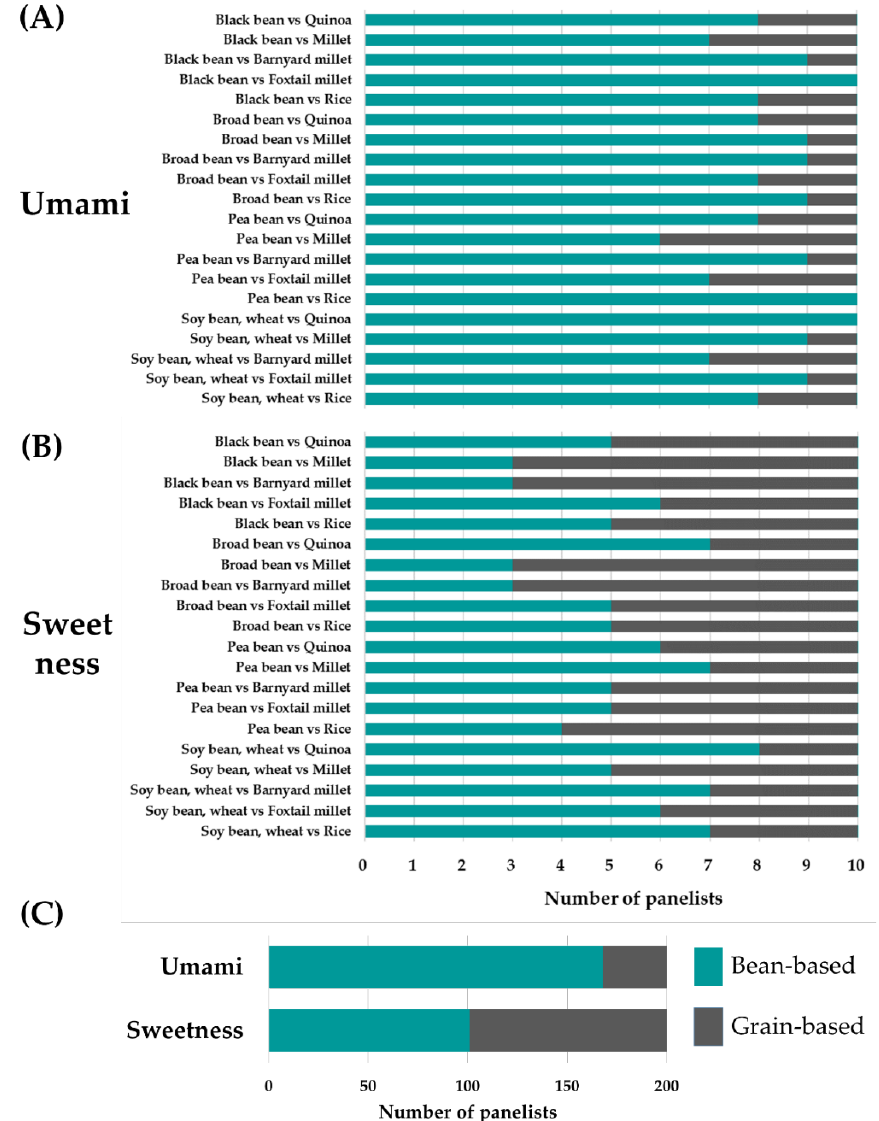
Figure 2. Paired comparisons of the intensities of umami and sweetness between grain-based and bean-based samples. ( A ), ( B ) Number of panelists that selected each sample in pairwise comparisons of soy-sauce-like seasonings made from grain and beans. ( C ) Number of panelists that selected soy-sauce-like seasonings made from grain and beans based on umami and sweetness.